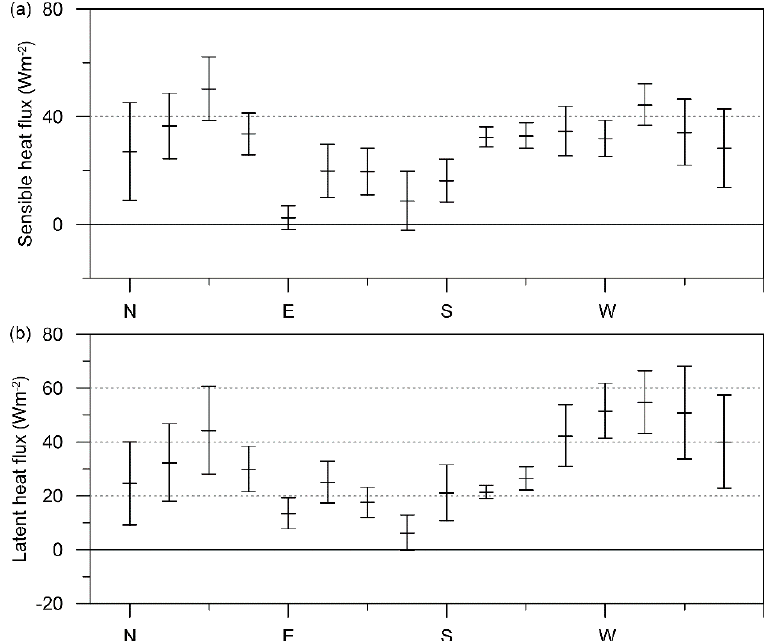
Figure 3. Mean and 95% confidence interval of sensible heat flux ( a ) and latent heat flux ( b ) depending on wind direction at study site between 23 January and 21 March, 2018.